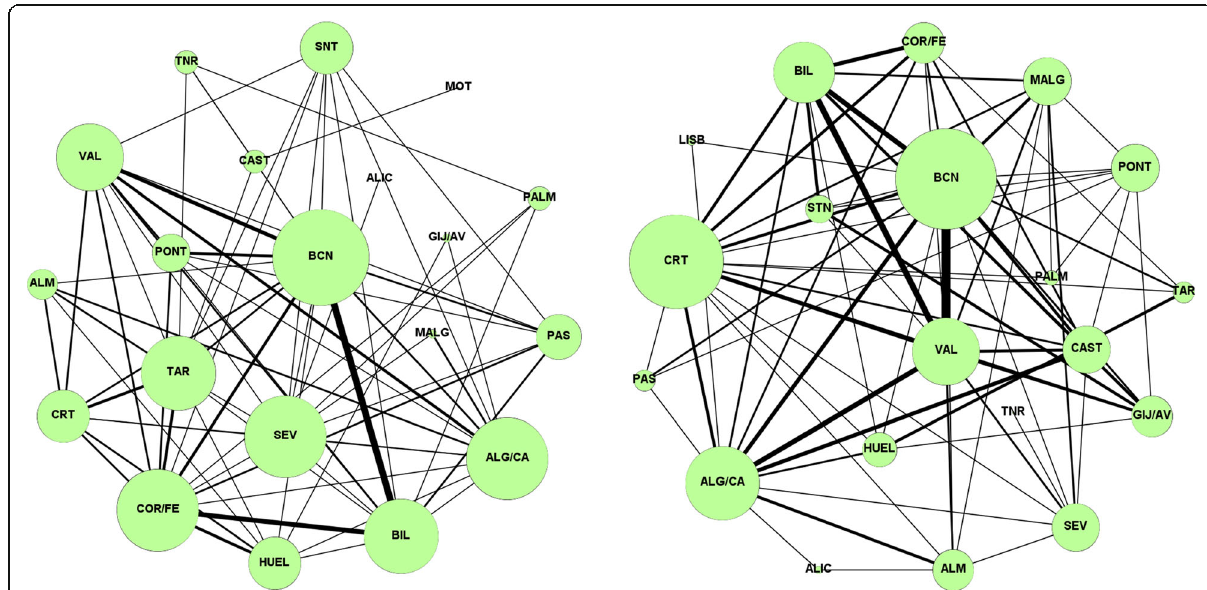
Fig. 6 Graphs representing the membership of pairs of ports to the same community for export flows in 2009 (left) and 2019 (right). The size of the nodes is proportional to their degree, and the thickness of the links is proportional to the number of communities shared by both